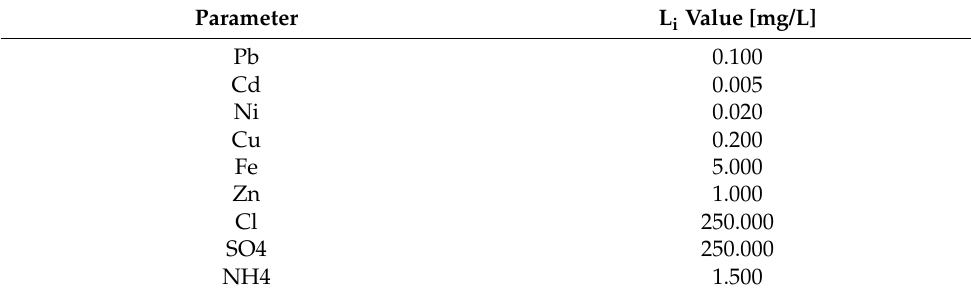
Table 1. Allowable limits of particular